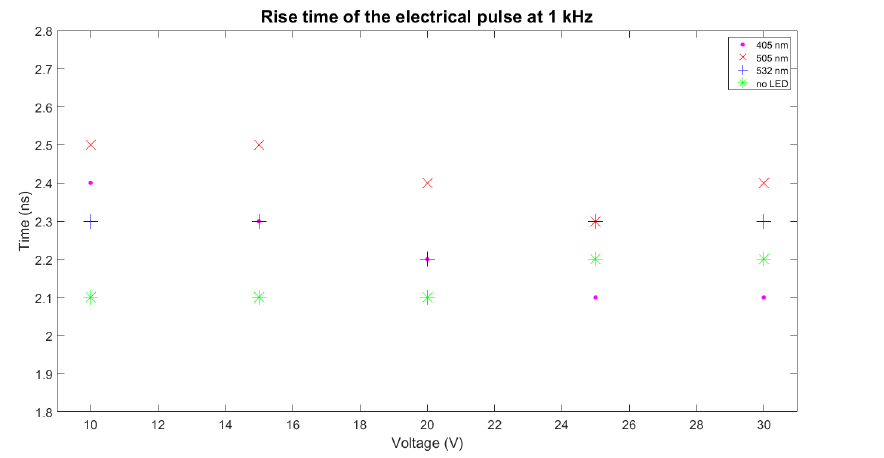
Figure 10. Rise time of the electrical pulse for 405, 505, and 532 nm LEDs. It is also presented the rise time without LED.